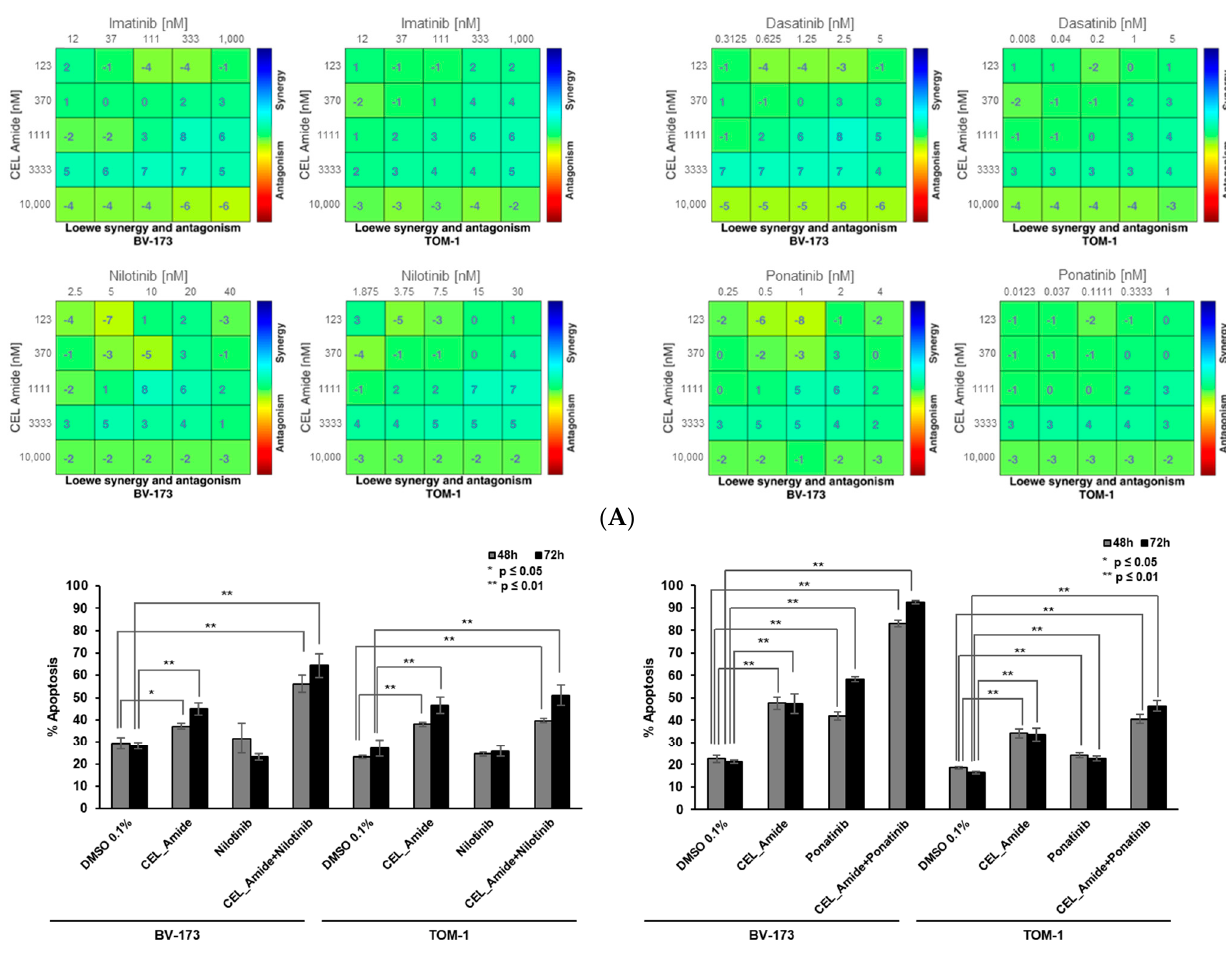
Figure 3. Drug combinations of LIMKi with BCR::ABL -targeting TKI inhibitors in BCR::ABL1 + ALL cell lines. BV-173 and TOM-1 cell lines were exposed for 72 h to increasing doses of different BCR::ABL inhibitors, including imatinib, dasatinib, and nilotinib or ponatinib, in combination with LIMKi CEL_Amide. The dose-response matrix was made according to the Loewe model. Results are shown from duplicates of 3 independent experiments ( A ). Apoptosis was measured in BV-173 and TOM-1 cell lines after 48 and 72 h exposure to CEL_Amide (1500 nM), nilotinib (25 nM), and ponatinib (1 nM), alone or in combination. Results are shown as mean ± SEM from duplicates ( n = 3) ( B